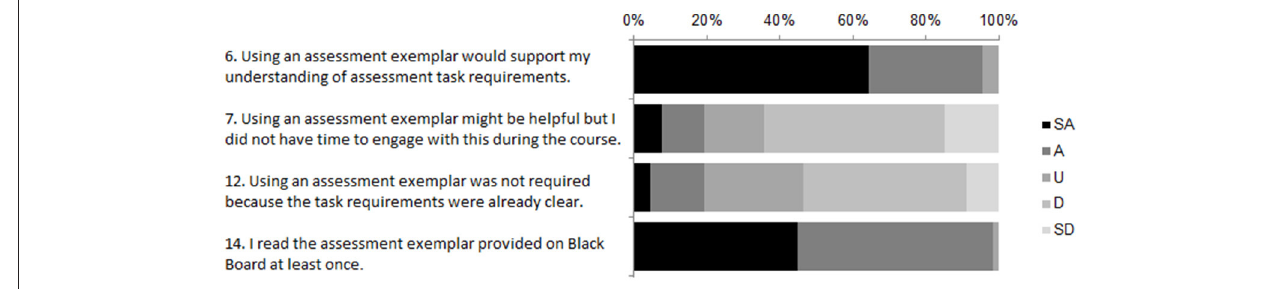
FIGURE 1 | Responses to questions about students’ perceived value of